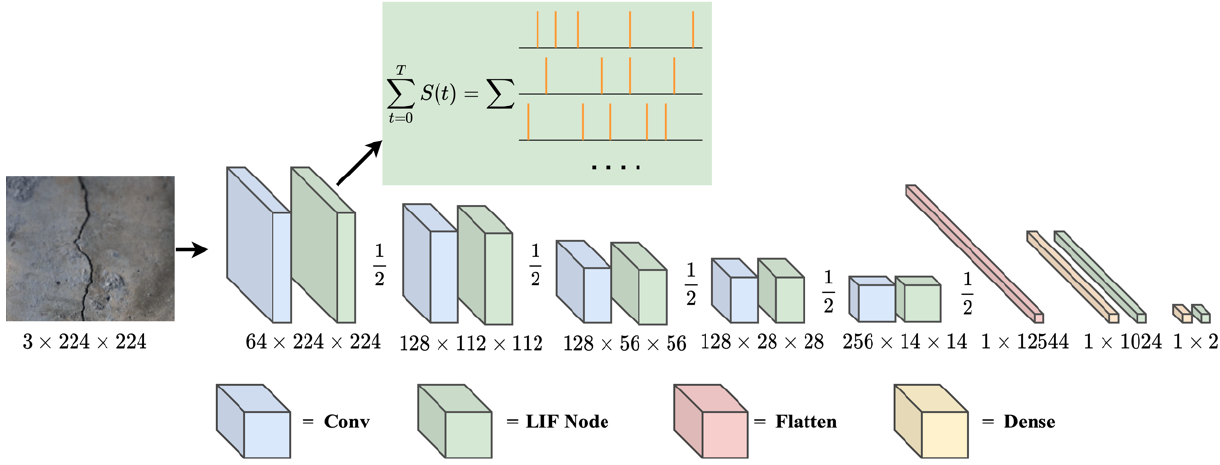
Figure 1. The architecture of the DCSNN for bridge damage detection.